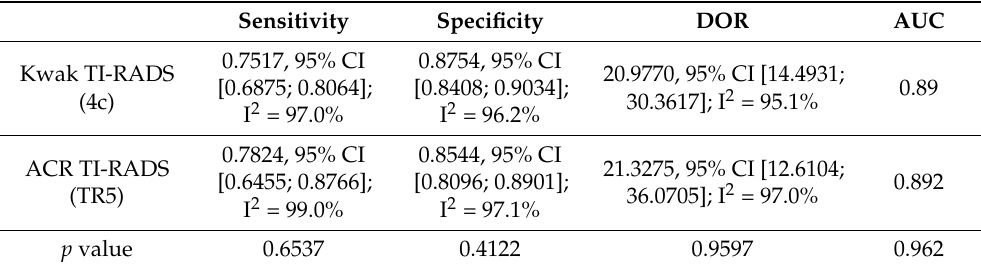
Table 4. Direct comparison of Kwak (4c) and ACR TI-RADS (TR5) categories.